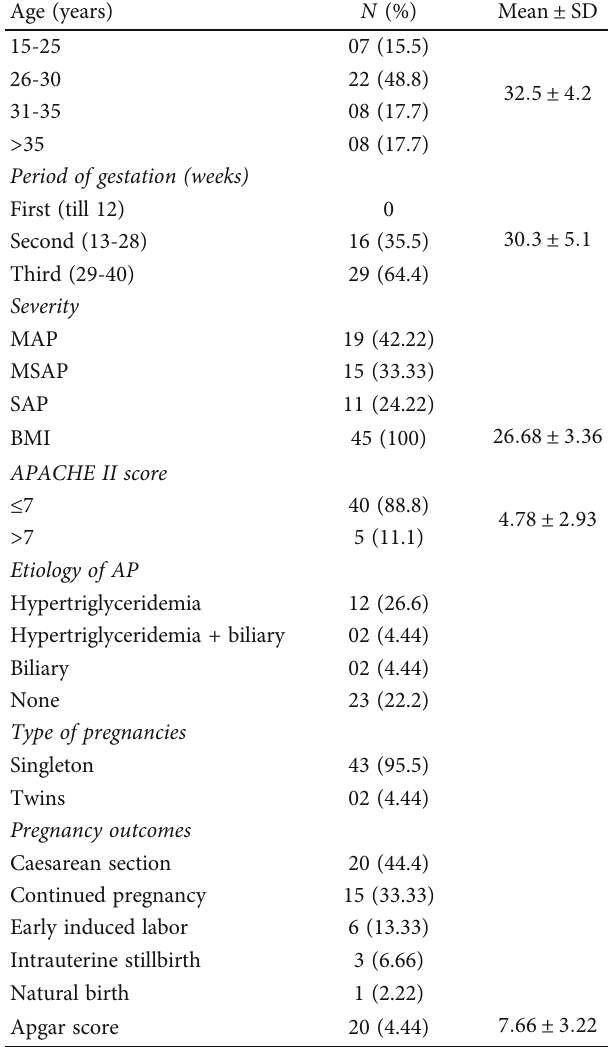
Table 1: Baseline demographic characteristics and clinical features of